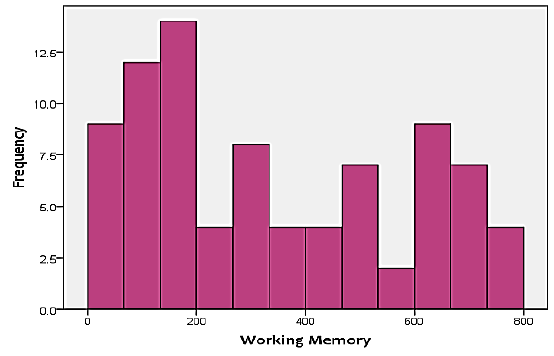
Figure 4. Distribution of working memory (WM) test scores.